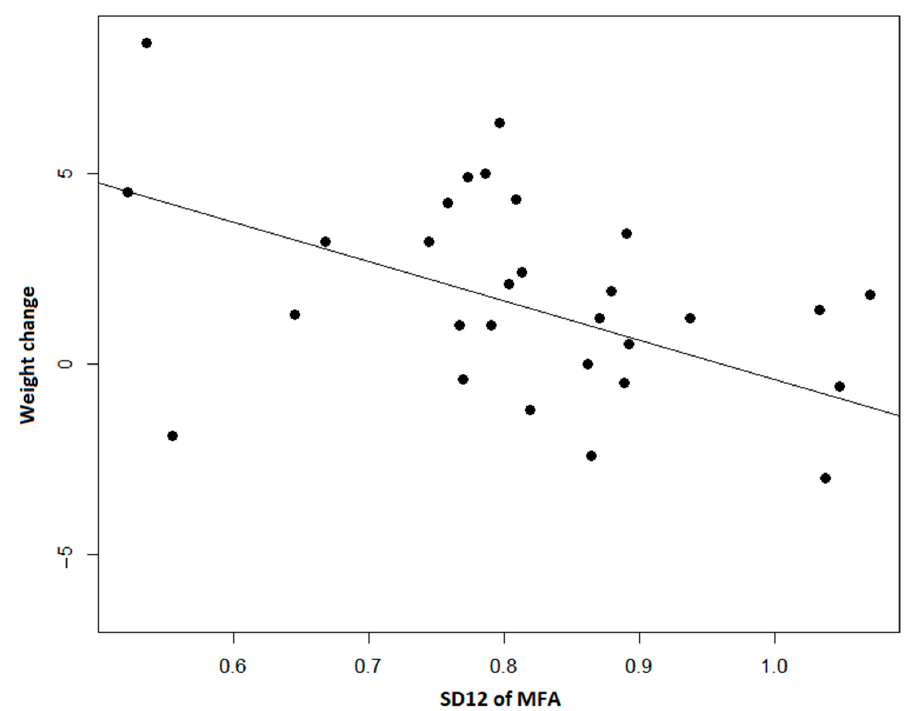
Figure 3. The ratio of SD1 and SD2 of Minutes Fairly Active (MFA) shows us a correlation between lower short-term and long-term variability ratios and weight. The smaller the short-term and long-term variability ratio, the smaller the decrease in weight observed ( p < 0.001).